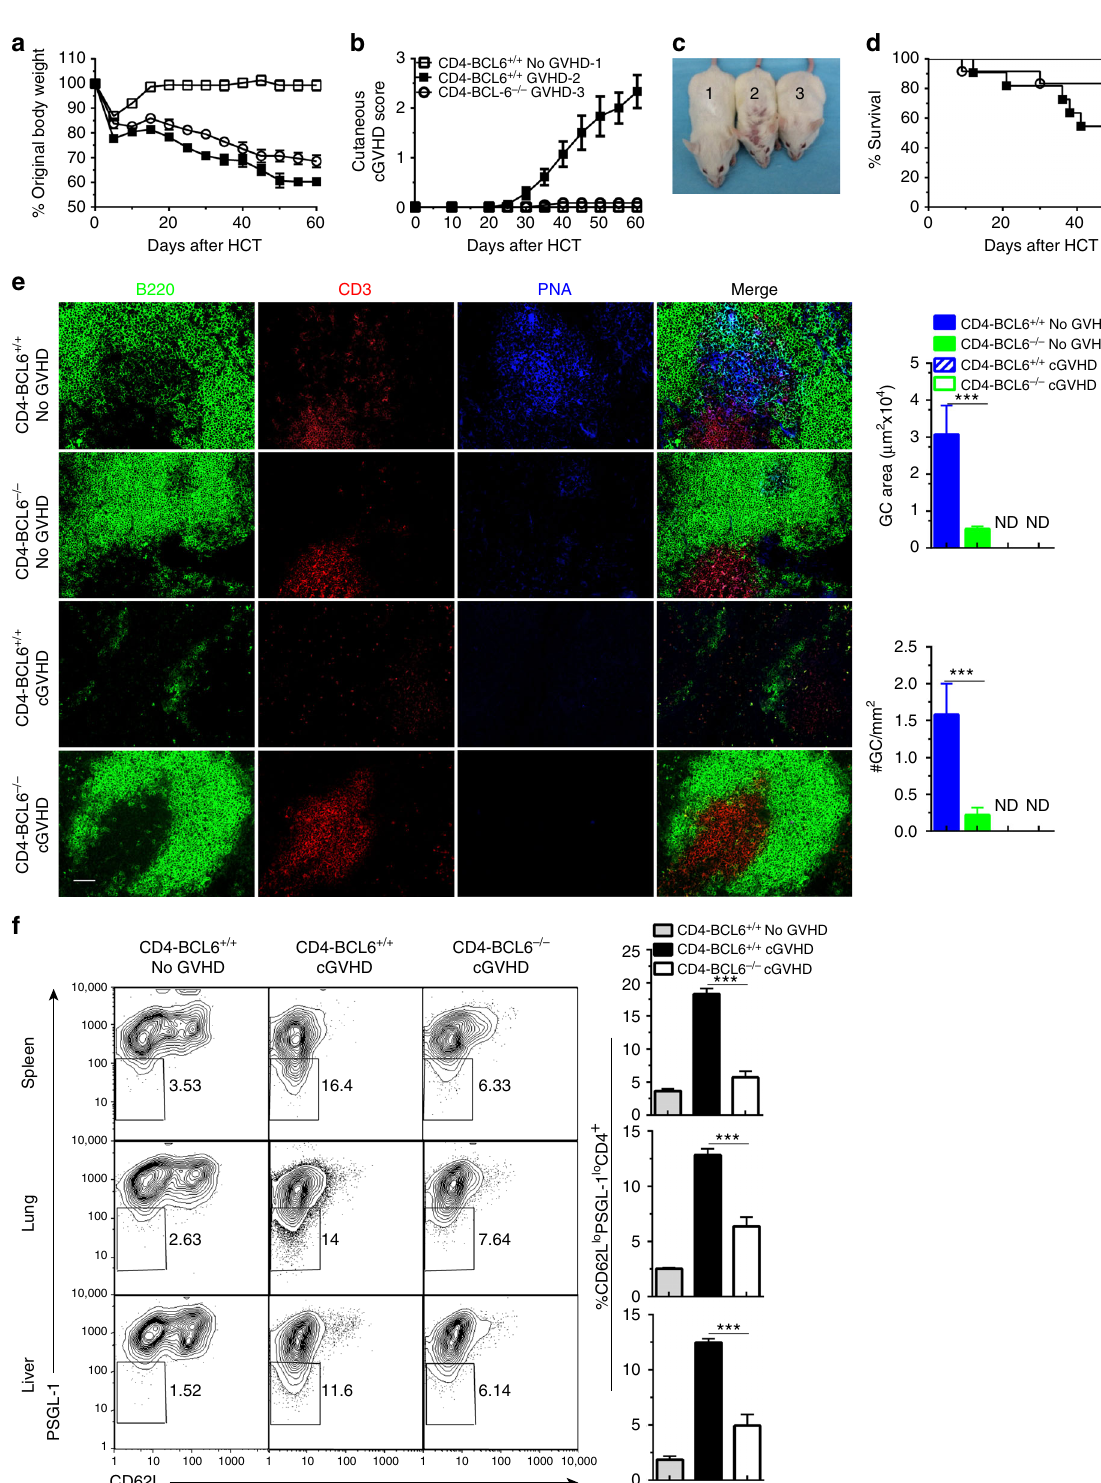
Fig. 6 BCL6 de fi ciency in donor CD4 + T cells prevents expansion of PSGL-1 lo CD4 + T cells and cutaneous cGVHD. BALB/c recipients were irradiated (850 cGy) and given 2.5 × 10 6 TCD-BM alone or 2.5 × 10 6 TCD-BM plus 1 × 10 6 splenocytes from either WT or B-BCL6 − / − C57BL/6 donors ( n = 12). cGVHD was monitored. a Percent body weight changes. b Cutaneous cGVHD scores (Group 3 versus Group 2: P < 0.001 two-way ANOVA). c Picture taken at day 60 after HCT (1 and 2 – CD4-BCL6 +/+ no GVHD and GVHD, 3 – CD4-BCL6 − / − GVHD). d Survival curve. e Sixty days after transplantation, spleens were harvested, and germinal centers were identi fi ed by immuno fl uorescent staining of B220, CD3, and PNA. GC area and numbers were measured and are shown as mean ± SE ( n = 4). f Twenty-one days after HCT, mononuclear cells from spleen, lung, and liver were stained for CD4, CD44, PSGL-1, and CD62L. Gated CD4 + CD44 hi cells are shown as PSGL-1 versus CD62L. Percentages of CD62L lo PSGL-1 lo cells among CD4 + CD44 hi are shown as mean ± SE ( n = 8). *** P < 0.001, unpaired two-tailed Student ’ s t test. CD4-BCL6 +/+ no-GVHD = CD4-BCL6 +/+ TCD-BM; CD4-BCL6 − / − no-GVHD = CD4-BCL6 − / − TCD-BM; CD4-BCL6 +/+ cGVHD = CD4-BCL6 +/+ TCD-BM + CD4-BCL6 +/+ splenocytes; CD4-BCL6 − / − cGVHD = CD4-BCL6 − / − TCD-BM + CD4-BCL6 − /